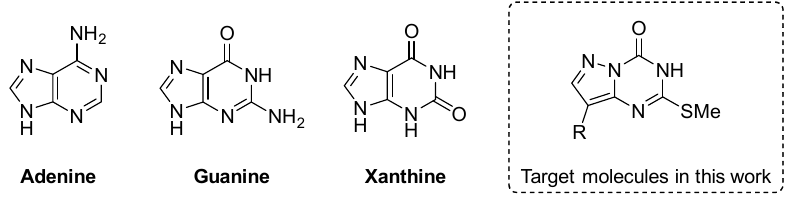
Figure 1. Structures of biogenic purines (adenosine, guanine, xanthine) and C8-functionalized 2-(methylsulfanyl)pyrazolo[1,5- a ]-1,3,5-triazin-4(3 H )-ones targeted in this study. This paper reports a convenient one-pot process for the synthesis of these 5-aza-9-deazapurines substituted in C8 by various functions (CN and CO 2 Et) and alkyl or (het)aryl groups.